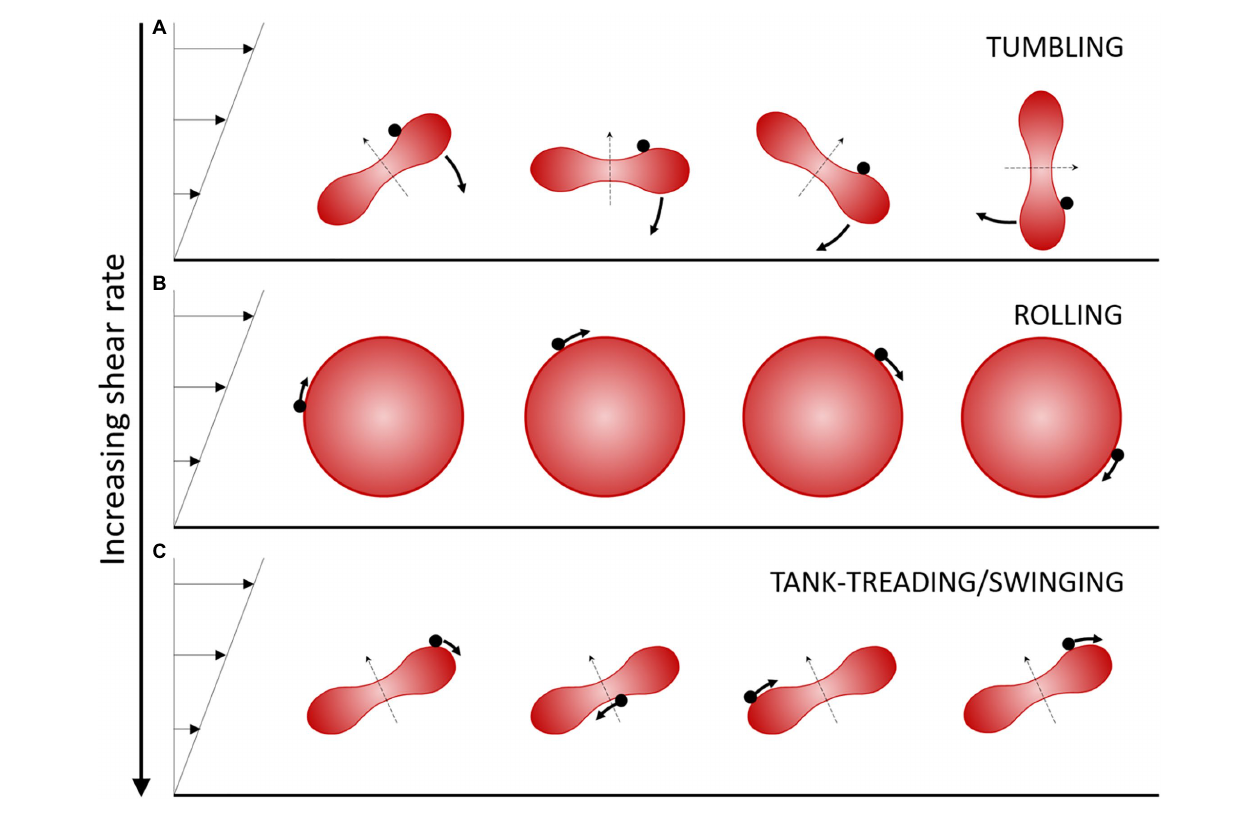
FIGURE 1 | Schematic view of the regimes of motion of a discocyte-shaped RBC in moderate shear flow. Flow is from left to right. The shear stress is increased from (A) to (C) . The RBC is illustrated over time perpendicularly to the shear plane. The black dot on the RBC displays a membrane element in motion. The thin dashed arrow indicates the axis of revolution of the RBC. (A) The tumbling/flip-flopping motion is observed at very low shear stress (typically <0.05–0.1 Pa for healthy RBCs). (B) The rolling motion is observed at intermediate shear stresses (typically 0.1–0.15 Pa for healthy RBCs). The axis of symmetry is perpendicular to the shear plane. (C) The tank-treading/swinging motion is observed at higher shear stress (typically >0.15 Pa for healthy RBCs). The axis of symmetry remains in the shear plane and the body of the RBC oscillates slightly around a fixed tilted position as the membrane rotates around